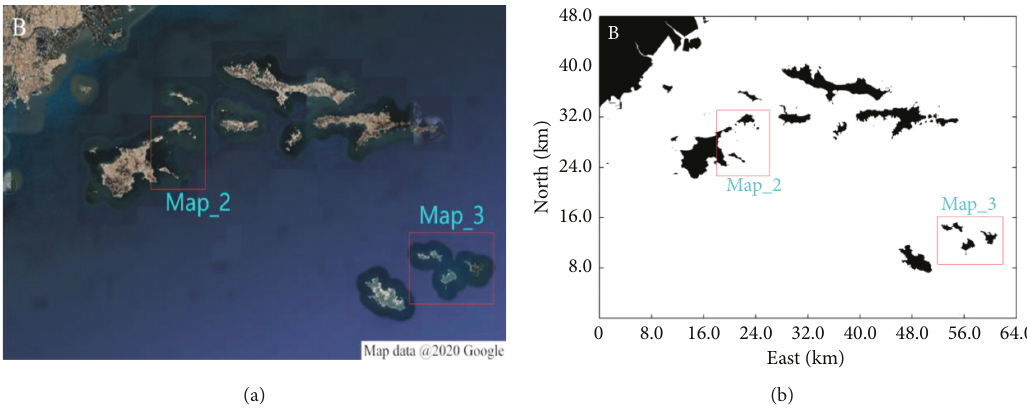
Figure 18: 6400 ∗ 4800(64km ∗ 48km) scale sea area map. (a) Original map. (b) Binarized